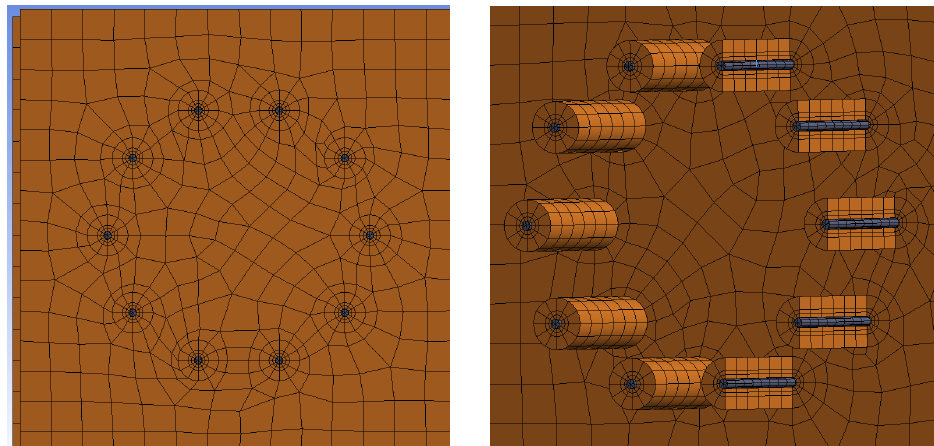
Materials 2022 , 15 , x FOR PEER REVIEW Figure 14. Finite ‐ element mesh for Experiment A, bolts and dowels. Figure 14. Finite-element mesh for Experiment A, bolts and dowels. Figure 14. Finite ‐ element mesh for Experiment A, bolts and dowels.